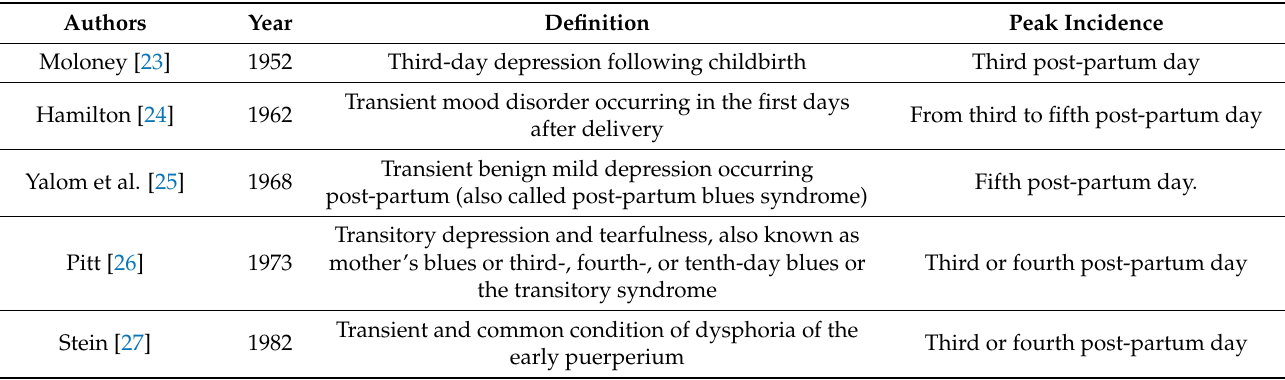
Table 1. Maternity Blues: definitions over